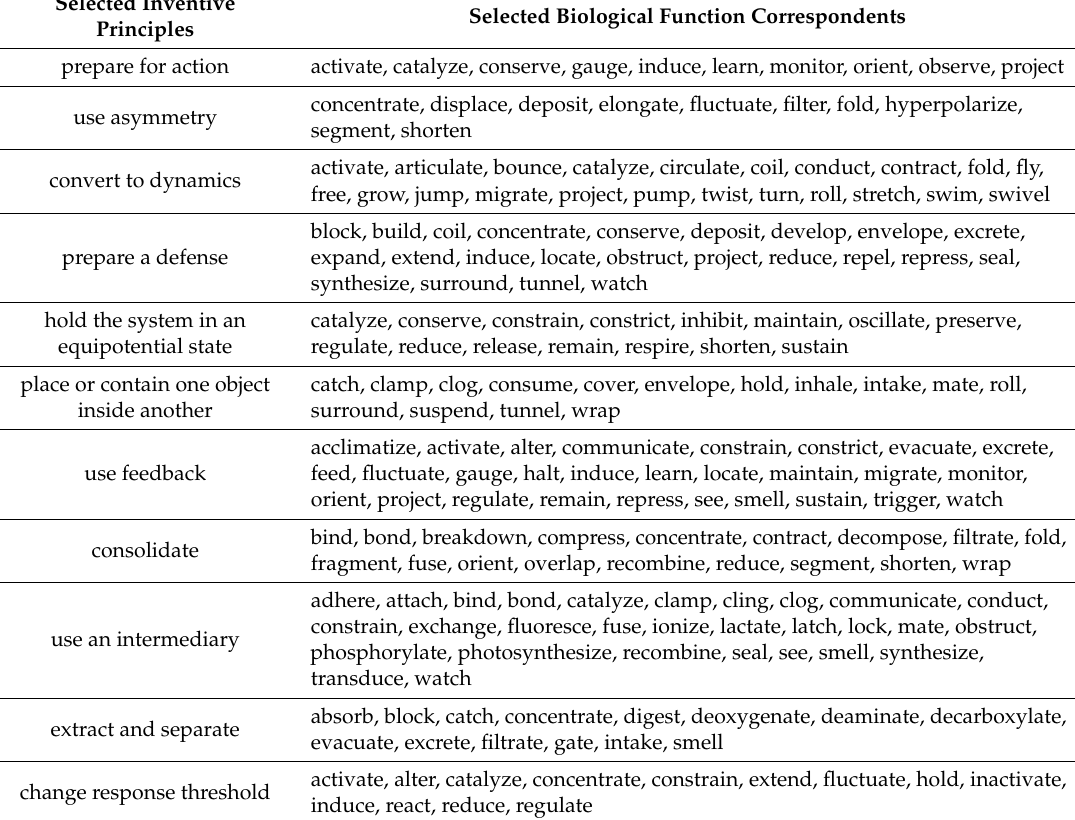
Table 1. List of all subjective biological function correspondents to IP